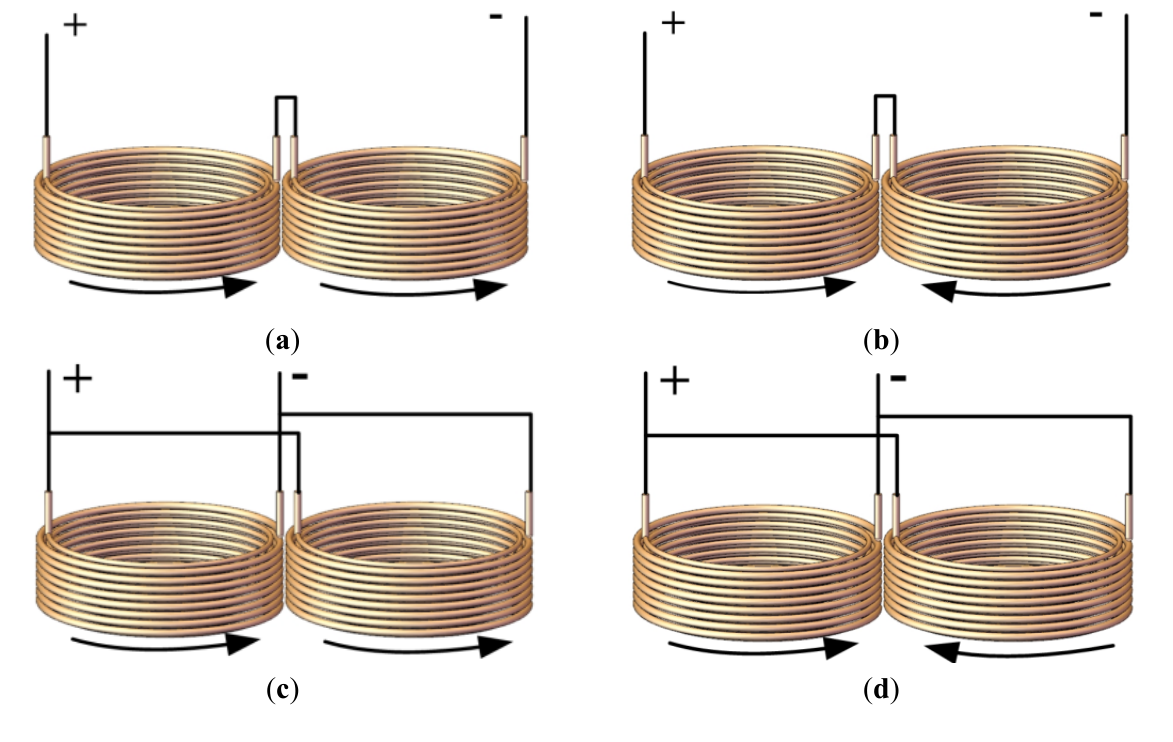
Figure 6. The configuration types of the dual-coil probes. ( a ) Type A. serial connected, same current direction; ( b ) Type B. serial connected, opposite current direction; ( c ) Type C. parallel connected, same current direction; ( d ) Type D. parallel connected, opposite current direction.